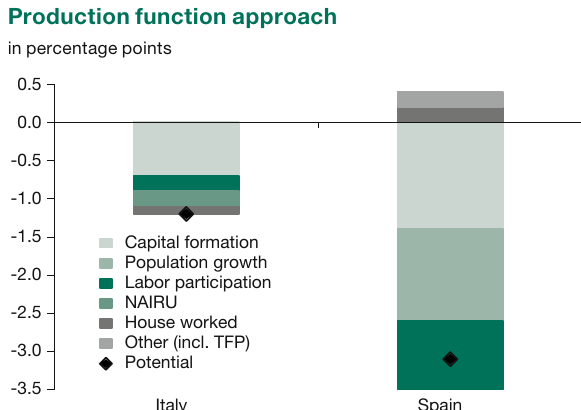
Real versus potential GDP growth Production function approach